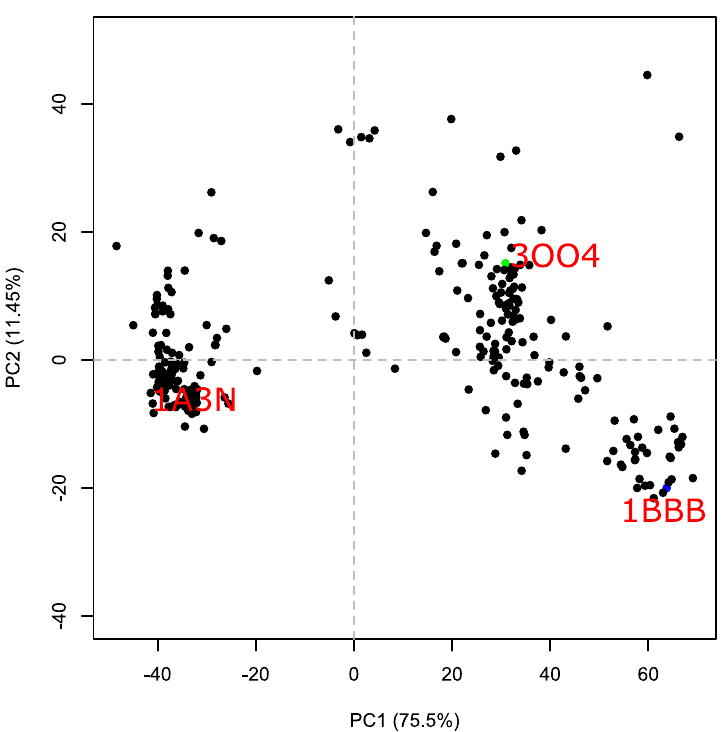
Fig 5. Hemoglobin principal component analysis. The abscissa and the ordinate represent the two main principal components with their variance written in